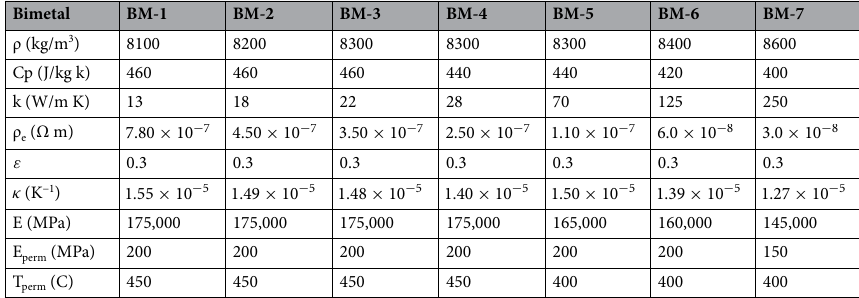
Table 2. Physical properties of the bimetals used in the experimental study.